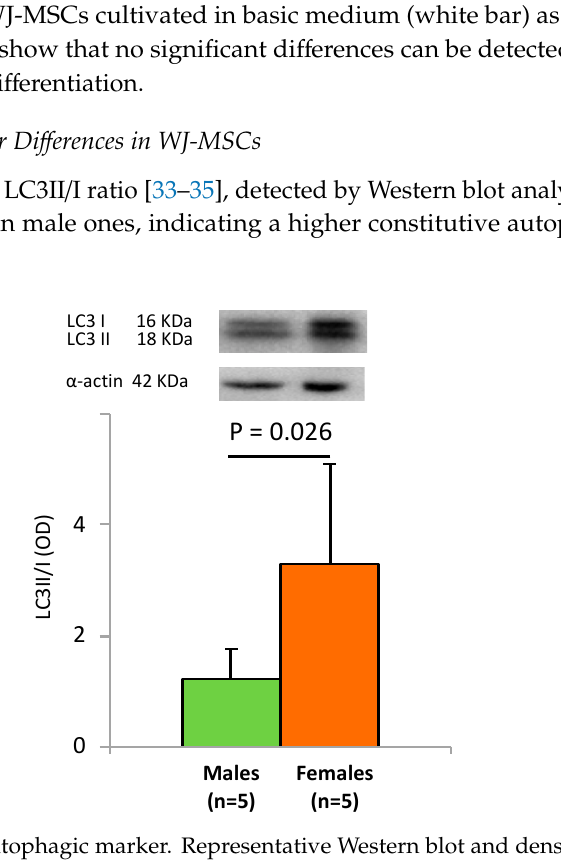
Figure 3. LC3 II / I ratio autophagic marker. Representative Western blot and densitometric analysis of LC3II / LC3I ratio in male and females WJ-MSCs. Values are expressed as means + SD from at least 5 experiments and normalized to actin levels.